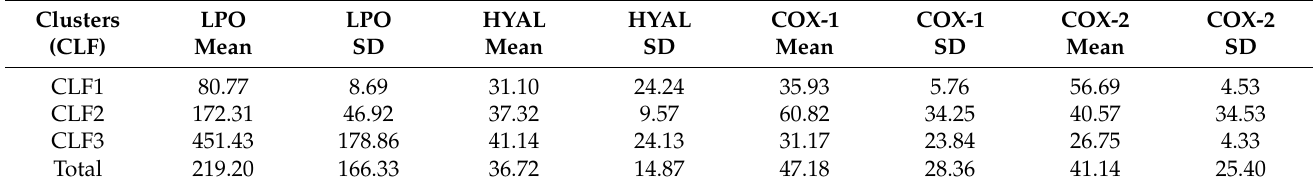
Table 10. Belonging to clusters (CLF) n = 8 of enzyme inhibitory activity